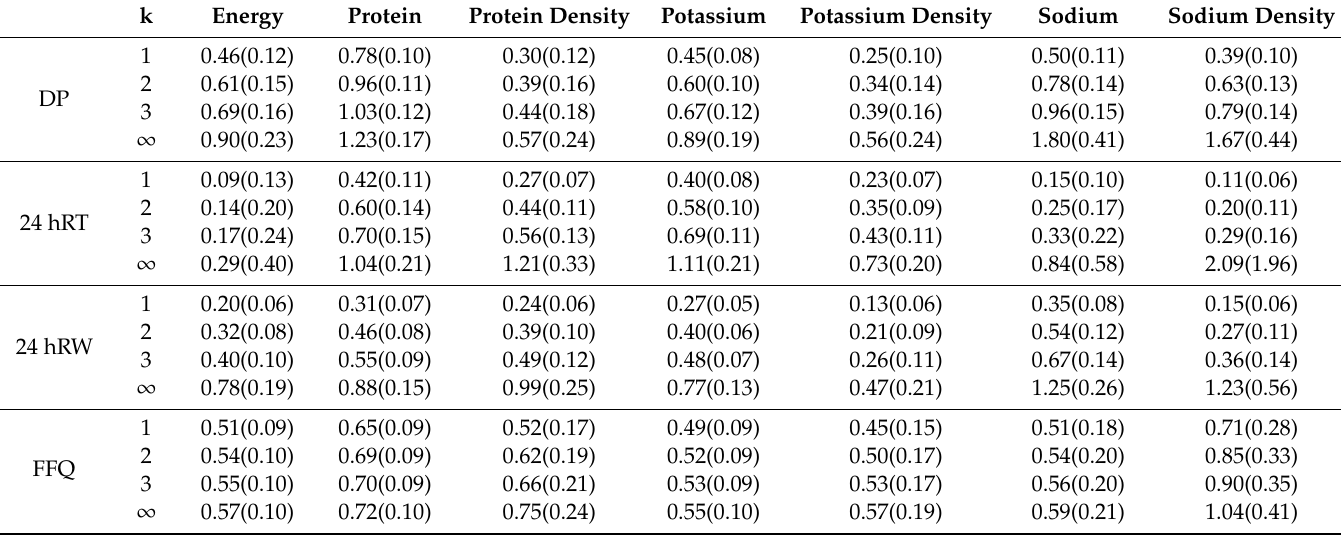
Table 3. Attenuation factors (AF) of energy, protein, potassium, sodium, and their nutrient densities for the DP, 24 hRT, 24 hRW and FFQ with the biomarker as the reference method